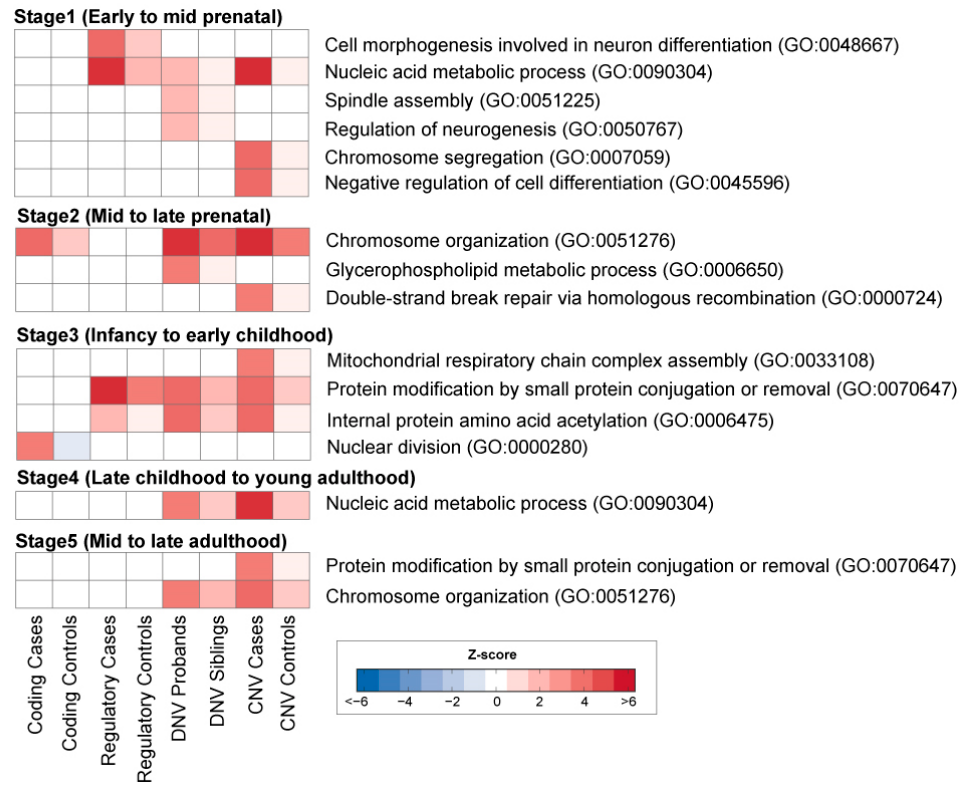
Figure 2. WGCNA analysis of human brain development. Heatmaps (bottom) show enrichment of rare variations in the co-expression gene modules. Heatmap (blue to red) reflects a significant association of variants as determined by z-score enrichment.